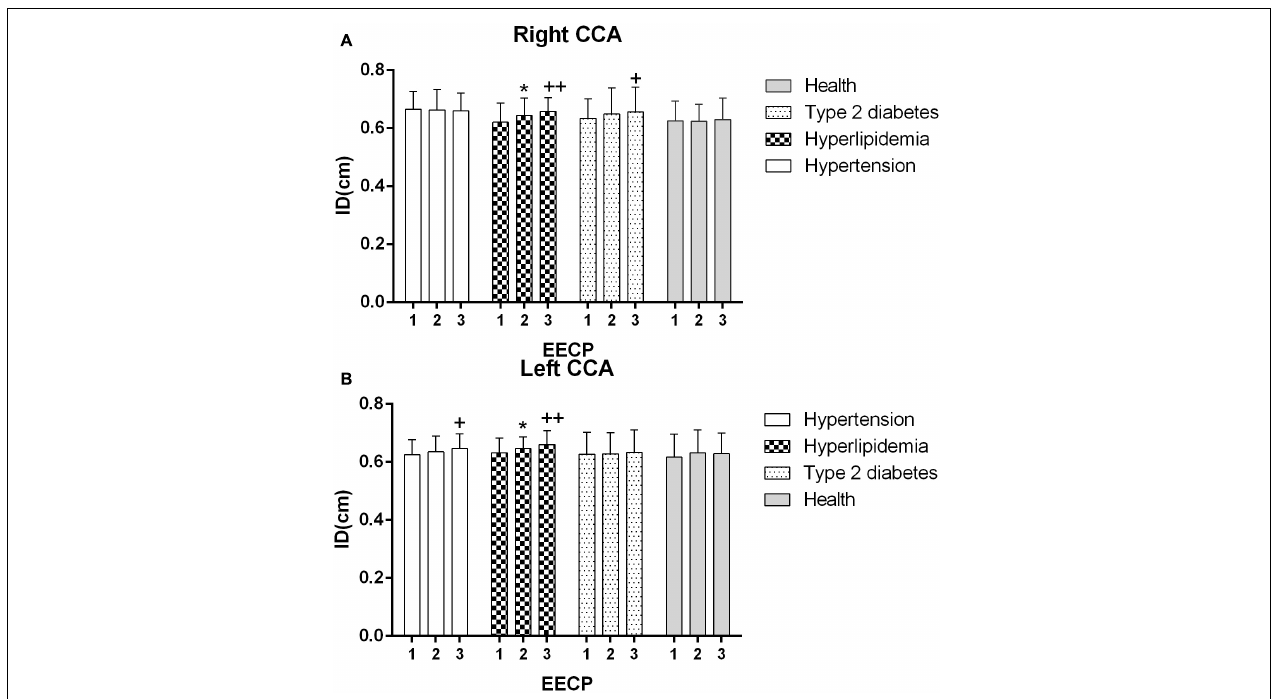
FIGURE 2 | Averaged inner diameters (IDs) in the right (A) and left (B) common carotid artery (CCA) in four groups before, during and after 45-min EECP. * P < 0.05 during EECP vs. pre-EECP, ** P < 0.01; ++ P < 0.05 post-EECP vs. pre EECP, ++ P < 0.01.